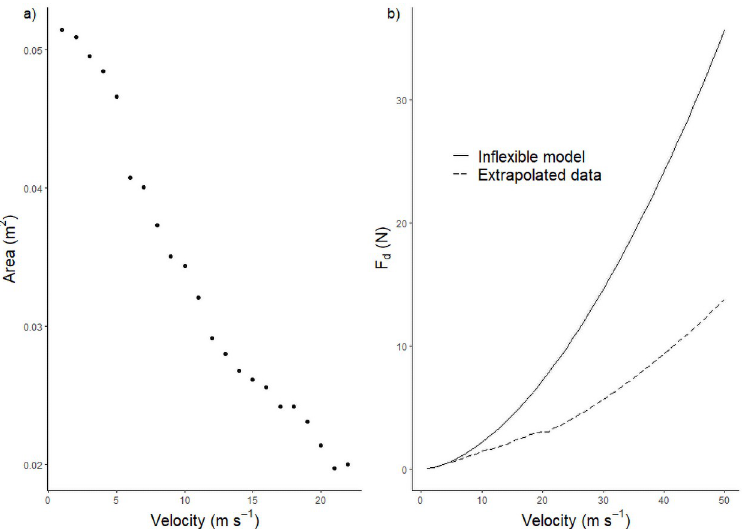
Fig 7. Frontal area reduction of one individual and the associated extrapolated reduction in drag forces. a) Decrease in the frontal area of an individual of G. monostachia (size: 35 cm) over increasing wind velocity. The rate of area reduction was decreasing and almost reaching a constant which was later used for extrapolation. b) Theoretical model showing the extent of drag force reduction on the individual of G. monostachia, assuming the frontal area of the plant stopped decreasing as plant reached maximum moment of bending as seen in